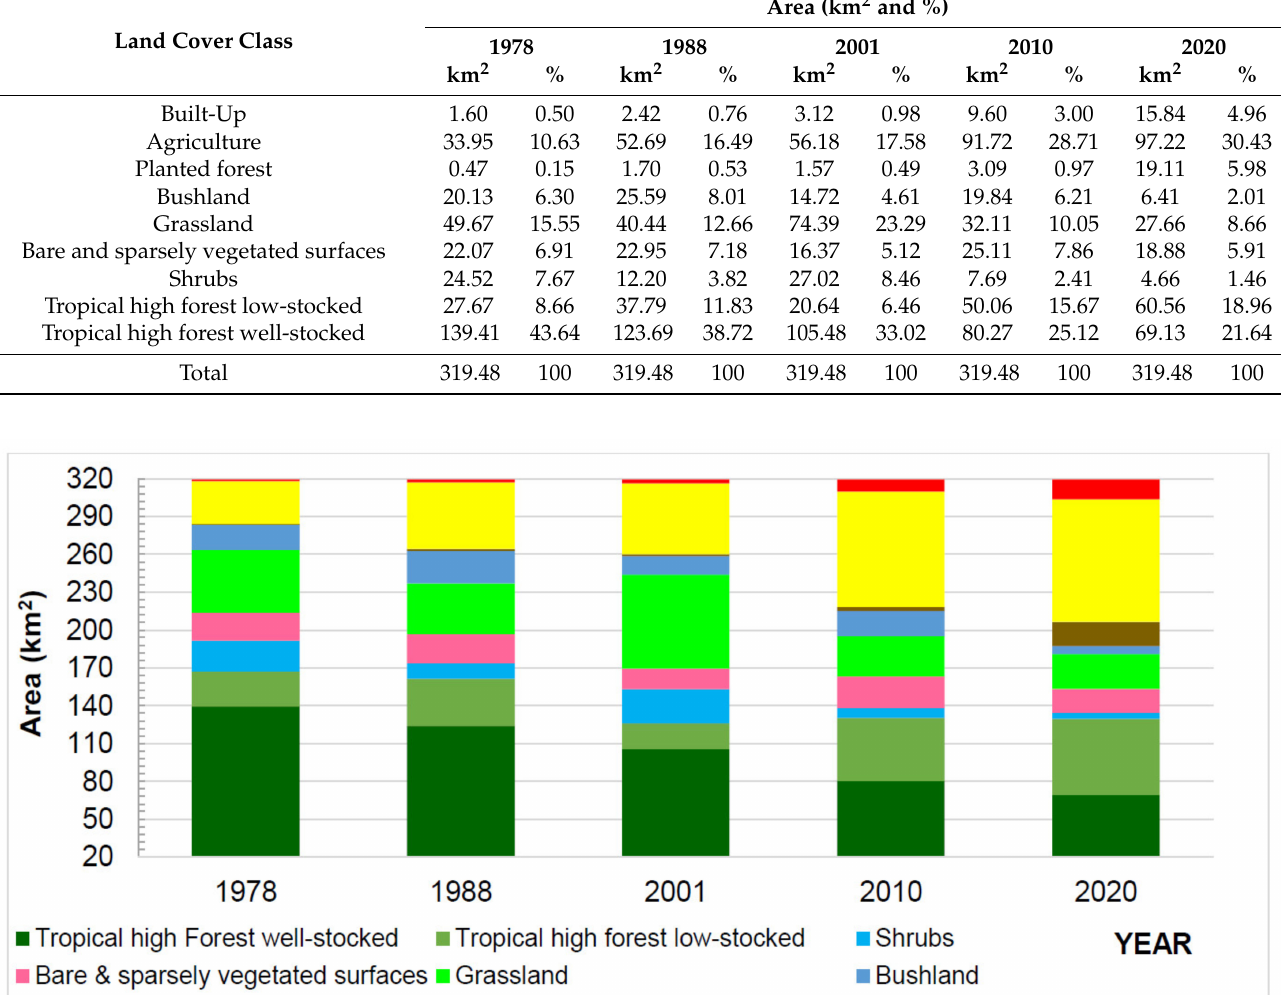
Table 5. The land cover change pattern from 1978 to 2020 indicates a general decrease